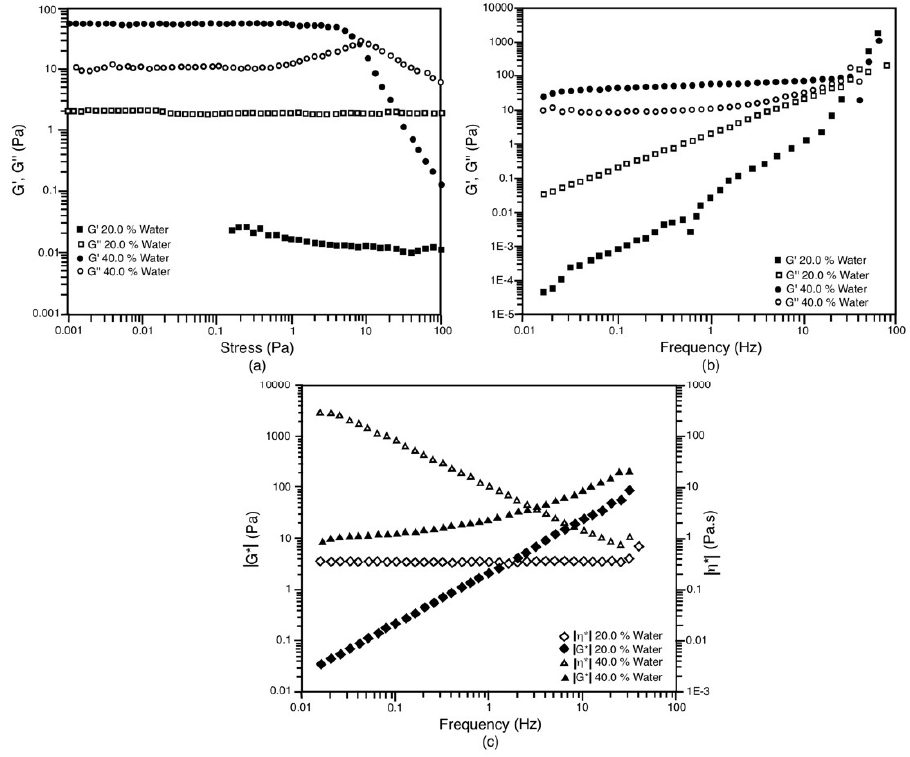
Figure 9. Oscillatory tests for the system with the dilution line S/O = 55/45 at 30 °C. The liquid crystal is in equilibrium with the Om phase and the Om and Wm phases in the case of 20% and 40 wt.% of water, respectively. ( a ) Amplitude shear stress sweep at 1 Hz; ( b ) Frequency sweep at 0.1 Pa; ( c ) Evolution of |G*| and | η *| against frequency.